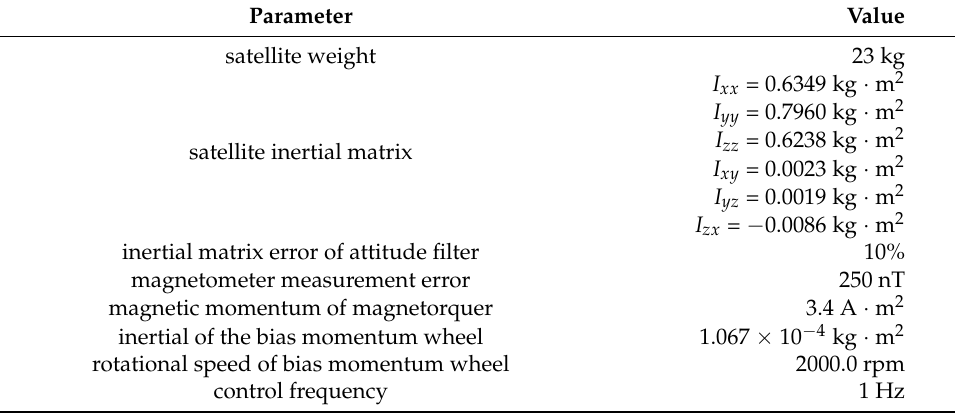
Table 3. Summary of the core parameters used in the